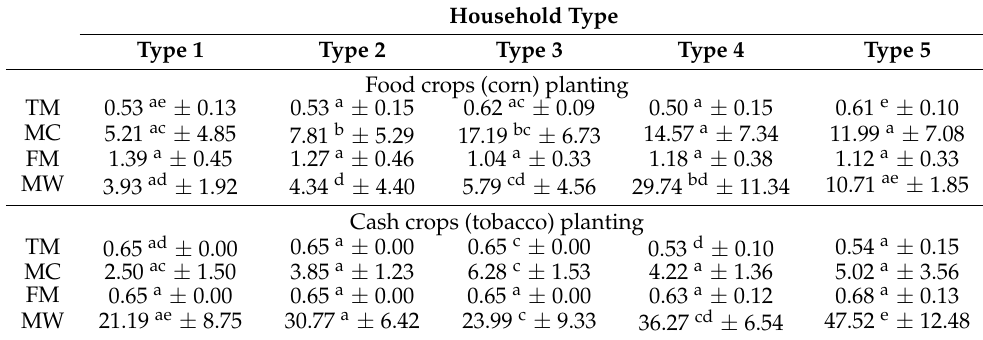
Table 6. Descriptive statistics (mean ± sd) of cropland physical disturbance behaviors in each of the five household